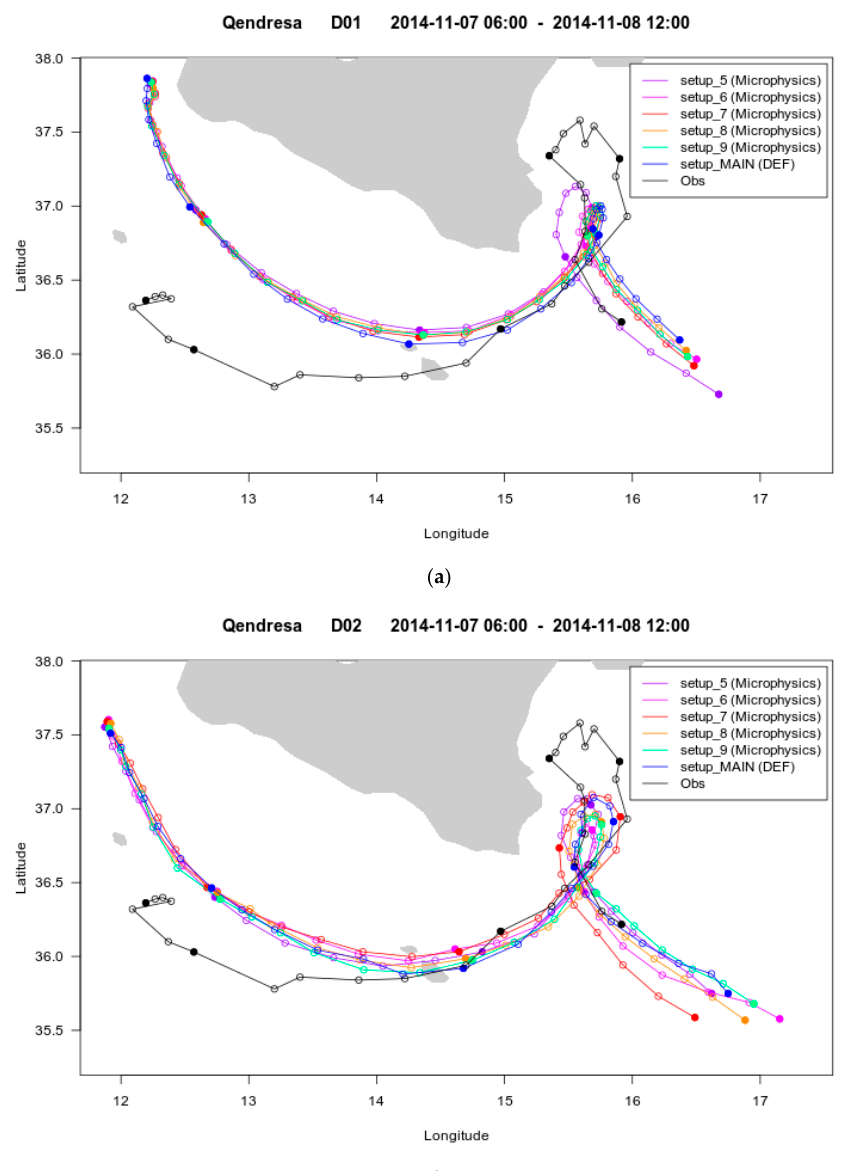
Figure 10. Trajectories of the TLC from 7 November at 06:00 UTC to 8 November at 12:00 UTC (depicted hourly) as predicted from the model MP experiments in the low ( a ) and high ( b ) resolution domain. The “combined” track (black line) and control run (setup-MAIN - blue line) are also shown. The position of the low-pressure center is denoted with solid dots every six hours, i.e., at 06:00, 12:00, 18:00 UTC November 7, and at 00:00, 06:00, 12:00 UTC November 8, and with open dots in all other hours.